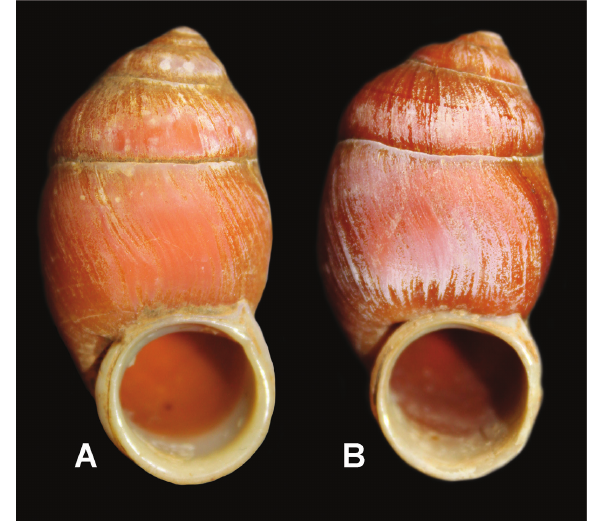
Figure 3. Pollicaria specimens sequenced in this study. A . CM 155302, orange phenotype (cf. P. crossei sensu Kongim et al. [2013]), 38.6 mm. B . CM 155307, red-brown phenotype (cf. P. rochebruni ), 24.7